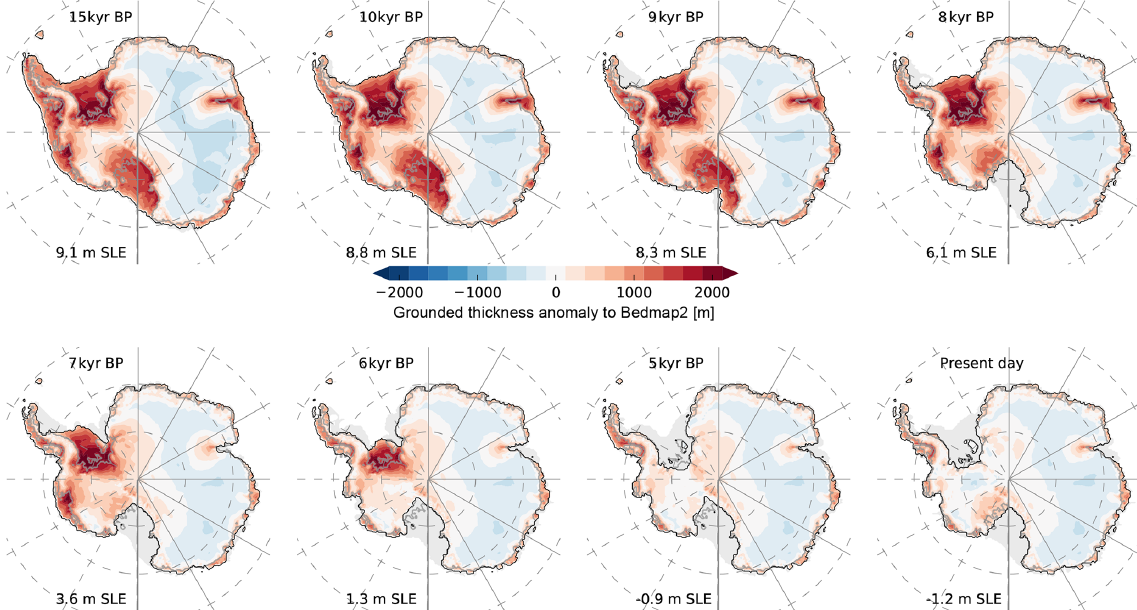
Figure 15. Snapshots of grounded ice thickness anomaly to present-day observations (Fretwell et al., 2013) over last 15kyr in best-fit simulation, analogous to Fig. 2 in Golledge et al. (2014). At LGM period grounded ice extends towards the edge of the continental shelf, with much thicker ice than present, mainly in West Antarctica. Retreat of the ice sheet occurs first in the Ross basin between 9 and 8kyrBP, followed by the Amery basin around 1kyr later and the Amundsen and Weddell Sea basin between 7 and 5kyrBP. East Antarctic Ice Sheet thickness is underestimated throughout the deglaciation period (light-blue shaded area).